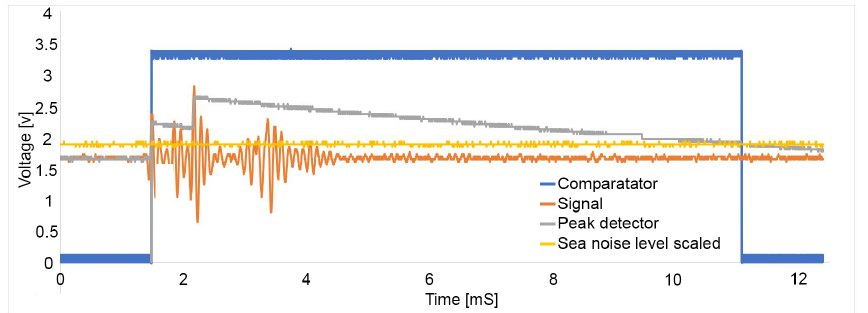
Figure 11. Real cetacean clicks and analog detection algorithm waveforms. High-pass-filtered input signal is in orange, V Ref in yellow, click envelope in grey and comparator output in